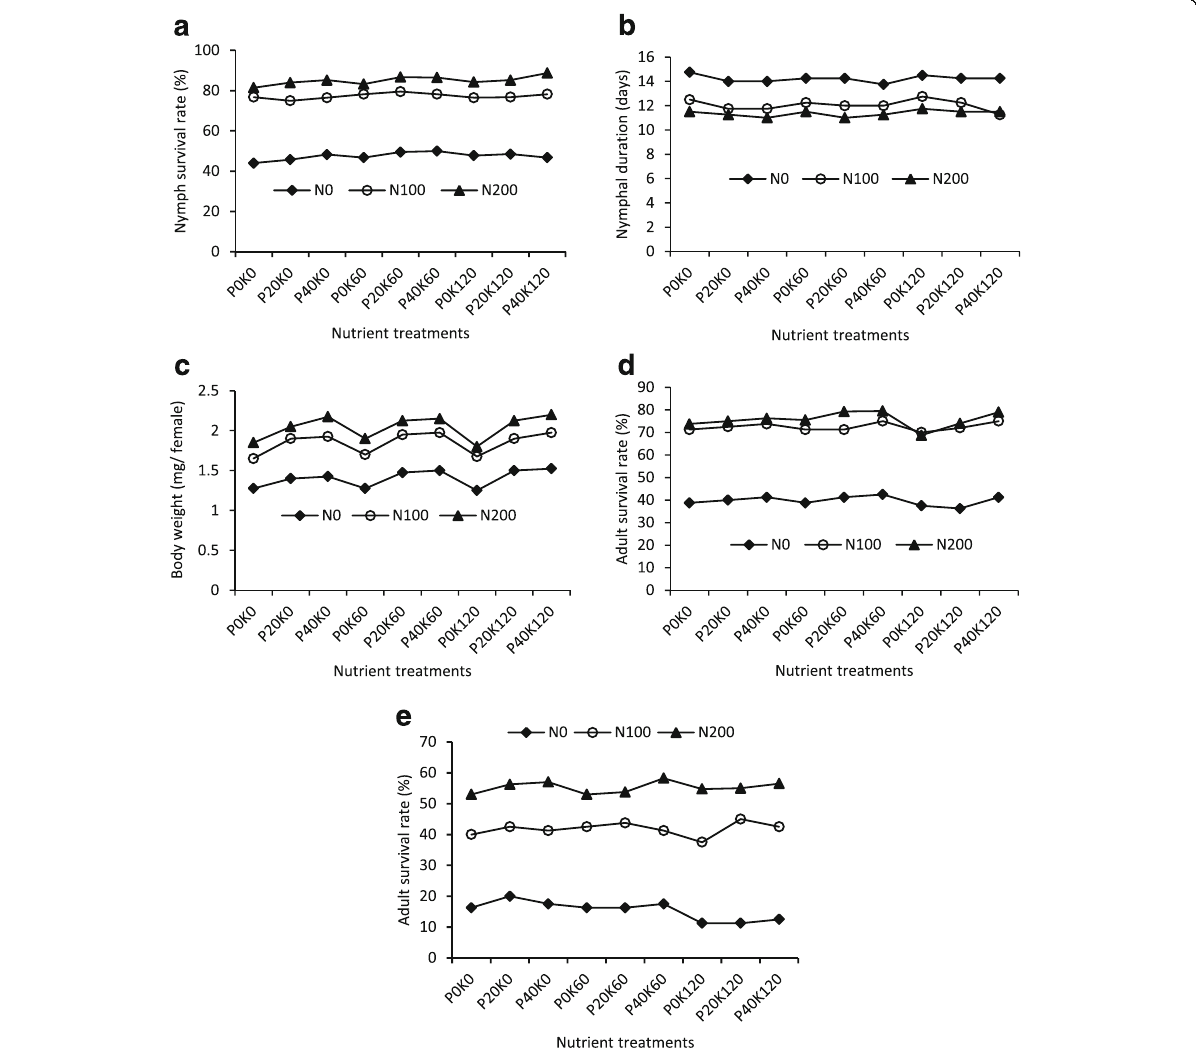
Fig. 1 Ecological fitness parameter of Nilaparvata lugens reared on rice plants exposed to three levels of N (N0, N100, and N200), P (P0, P20, and P40), and K (K0, K60, and K120) fertilization in nethouse. a Nymph survival rate (%), b nymphal duration (days), c adult body weight (mg), d adult survival rate at 5 days after infestation (DAI), and e adult survival rate at 7